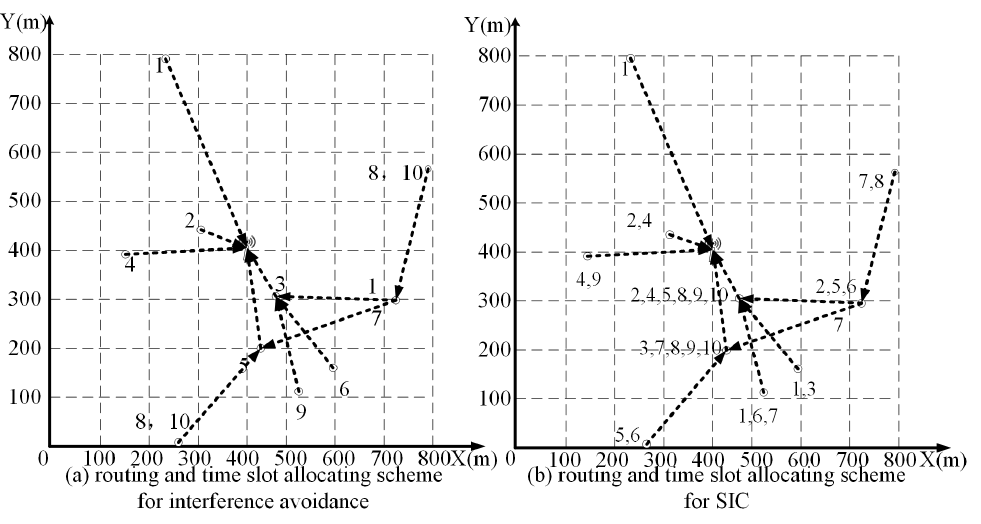
Figure 4. The 10-node sensor network and schemes in the two different